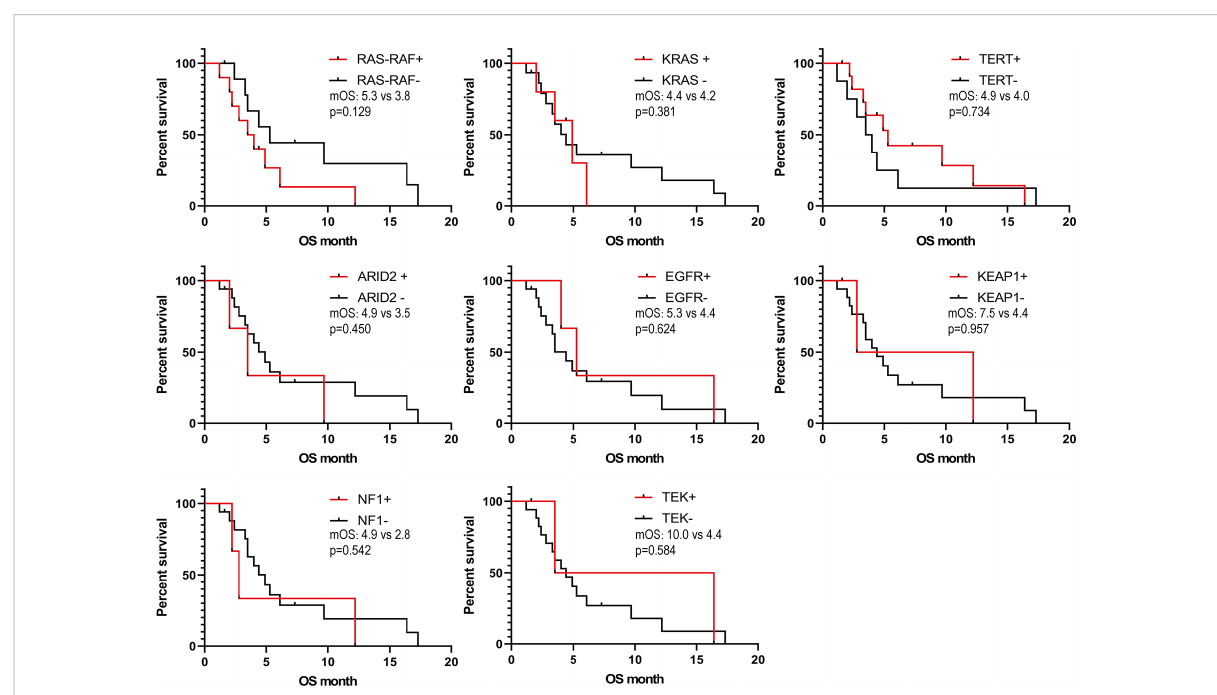
FIGURE 5 Kaplan- Meier estimates of overall survival in SHC comparing patients with different gene